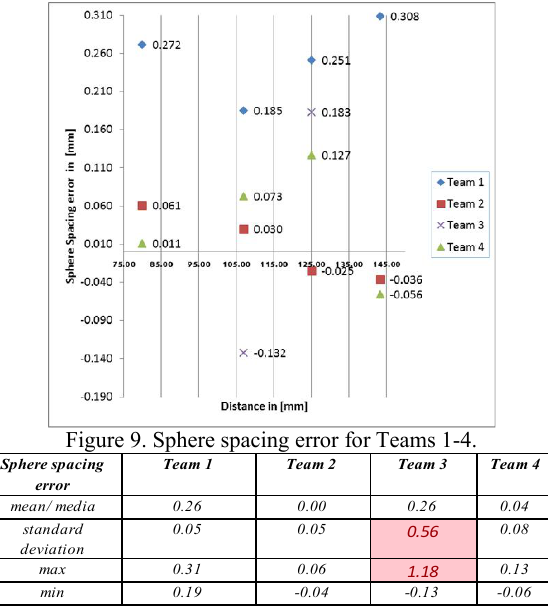
Table 2. Overall values of team for Sphere Spacing